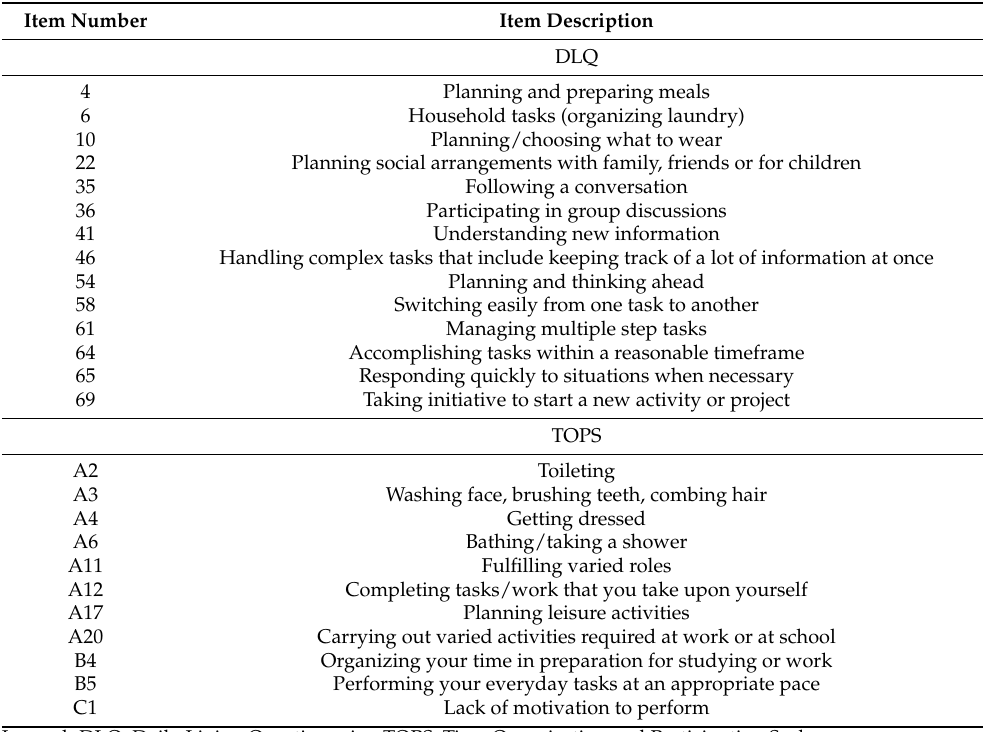
Table 4. Differences in TOPS and DLQ items with significance level of p ≤ 0.01 between the Parkin- son’s disease patients with and without suspected mild cognitive decline based on their cognitive functional